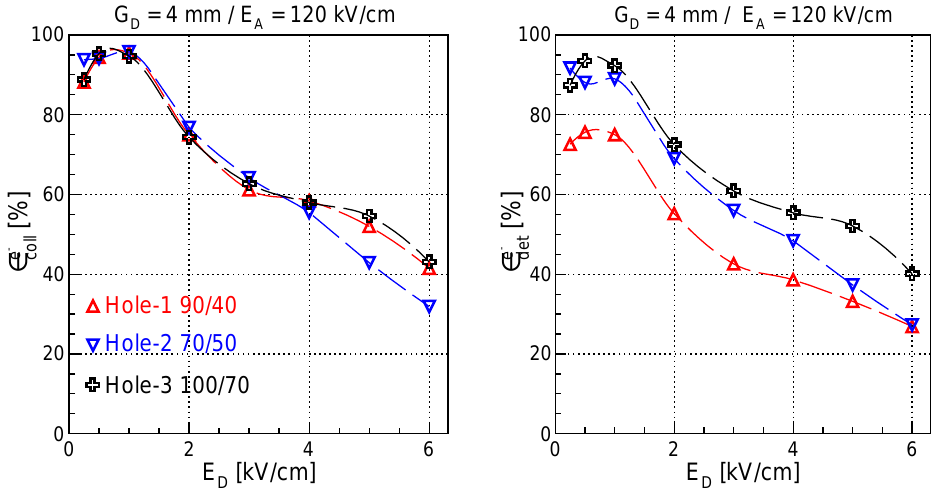
Figure 9. Collection efficiency ( left ) and detection efficiency ( right ) vs. E D